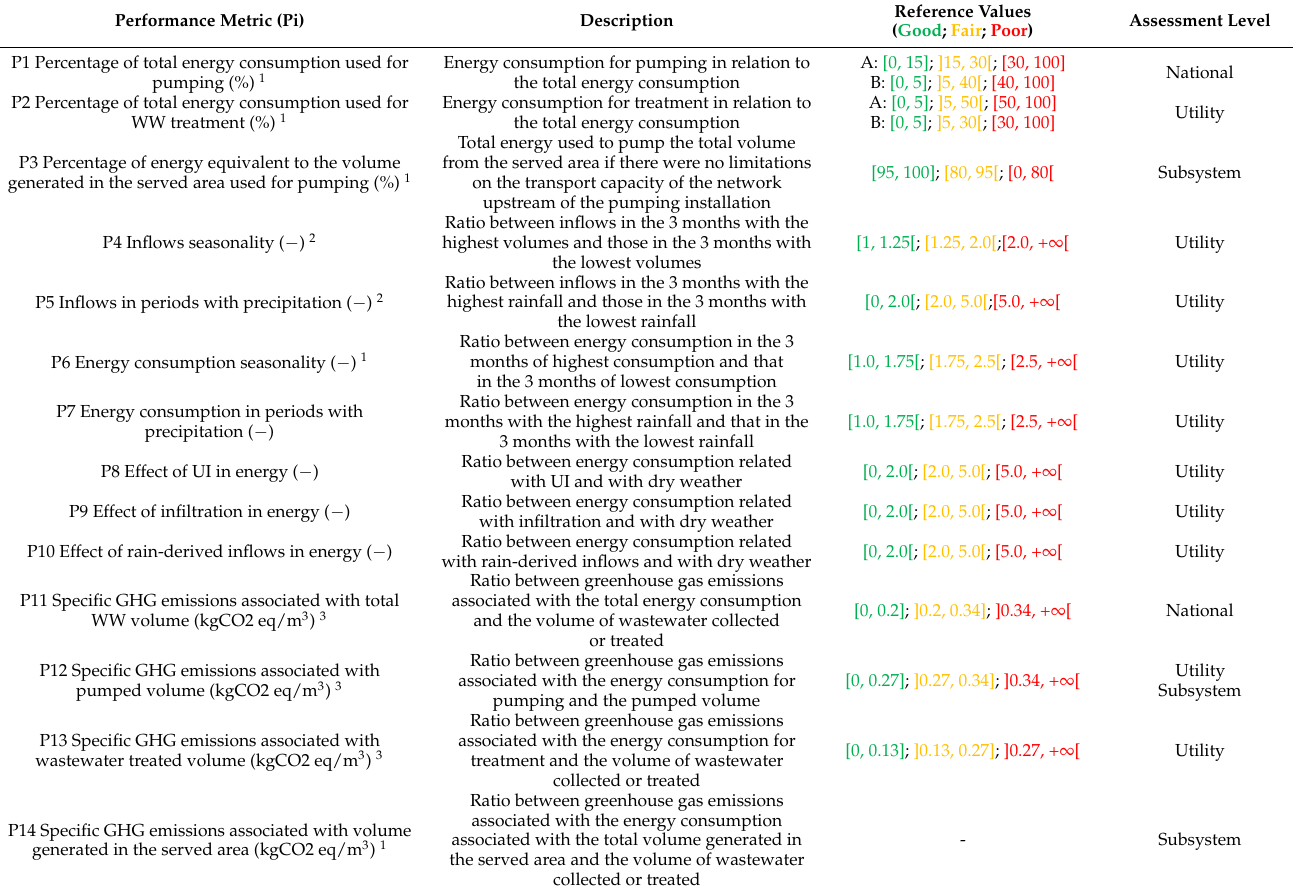
Table 1. Performance metrics to support evaluation of W-E-G